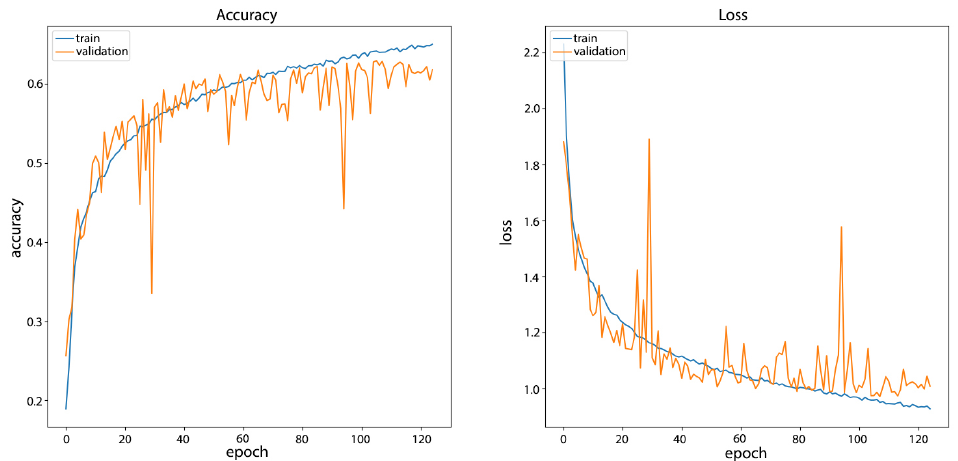
Figure 8. CNN Model_F2 training results on FairFace filtered dataset without plotted